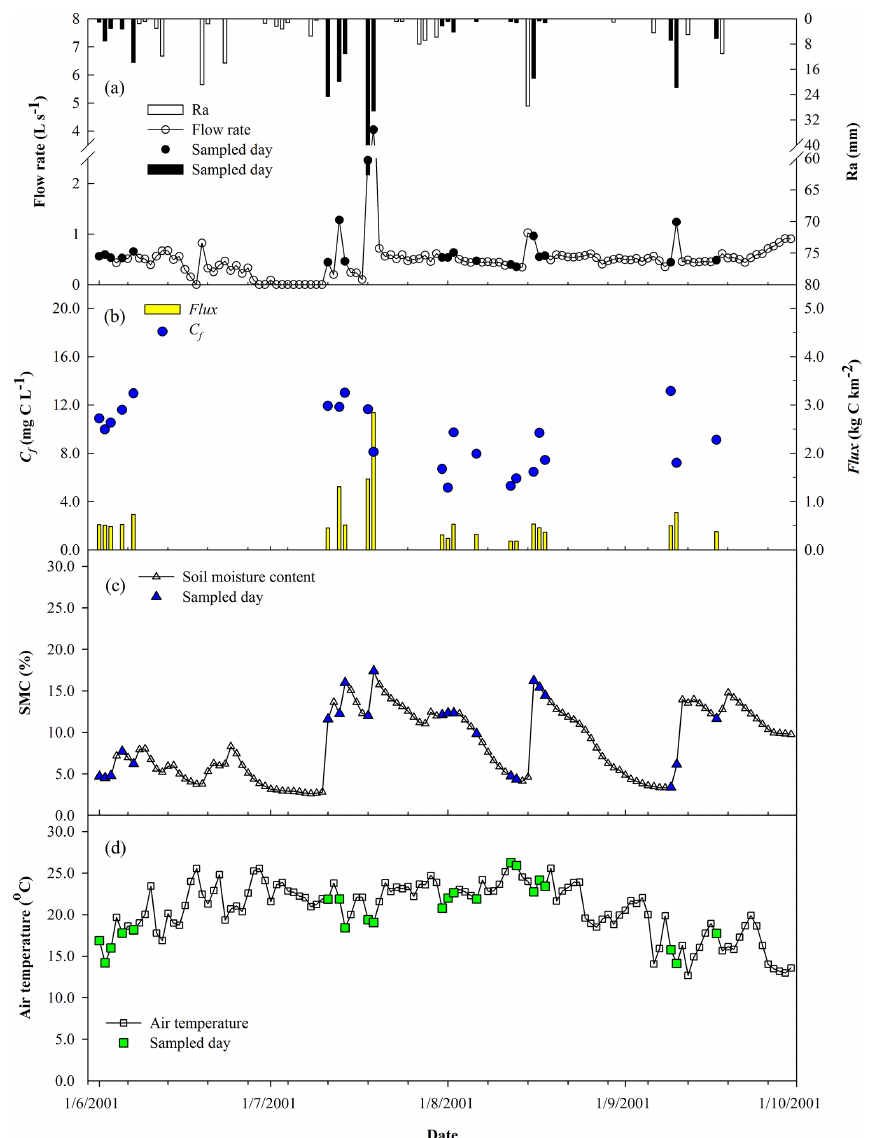
Figure 2. Temporal variations in R a (rainfall amount) and flow rate (a) , C f (flow-weighted mean concentration) and flux (b) , SMC (soil moisture content) (c) , and air temperature (d) during the concentrated rainfall season (June–September